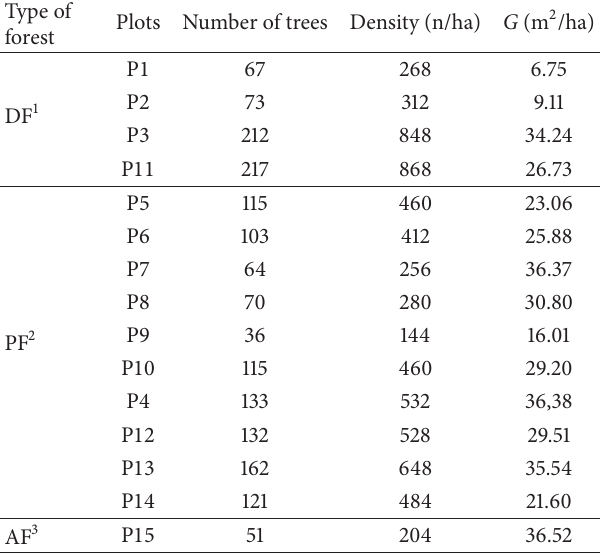
Table 1: Distribution of number of plots inside each type of